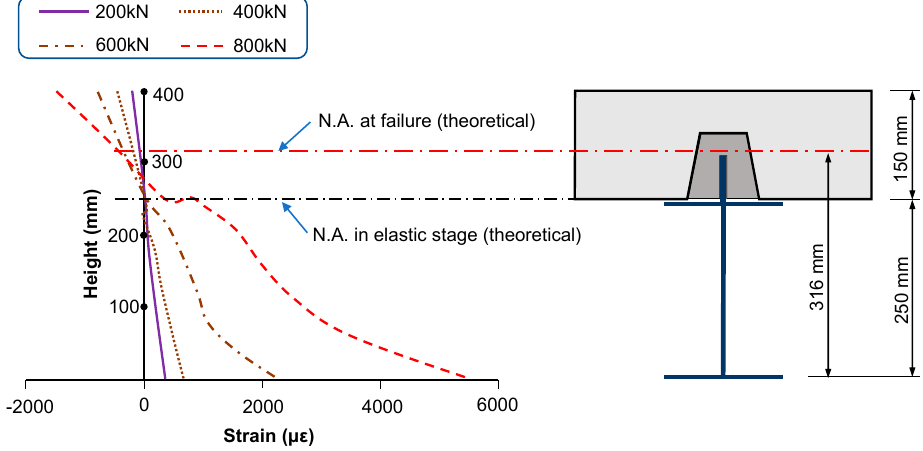
Figure 11. Longitudinal strain distributions over mid-span section of Beam 1.